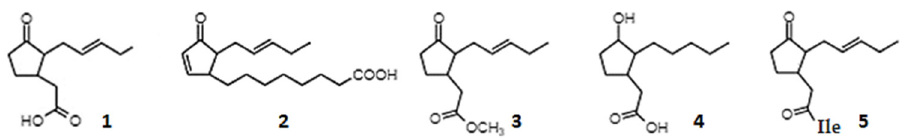
Figure 1. Chemical structures of several jasmonates: JA, (3-oxo-2-(2-pentenyl) cyclopentaneacetic acid ( 1 ); 12-oxo-phytodienoic acid ( 2 ); MeJA ( 3 ); (3-hydroxy-2-pentylcyclopentyl)-acetic acid ( 4 ); and jasmonoyl-L-isoleucine ( 5 ).